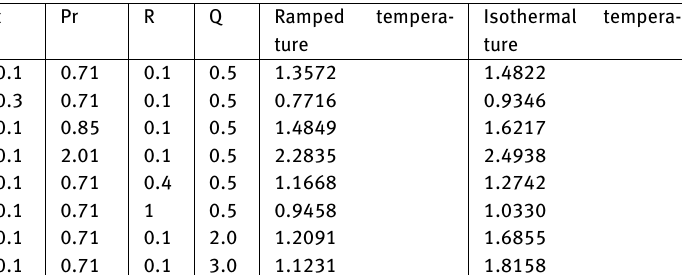
Table 4: Nusselt number